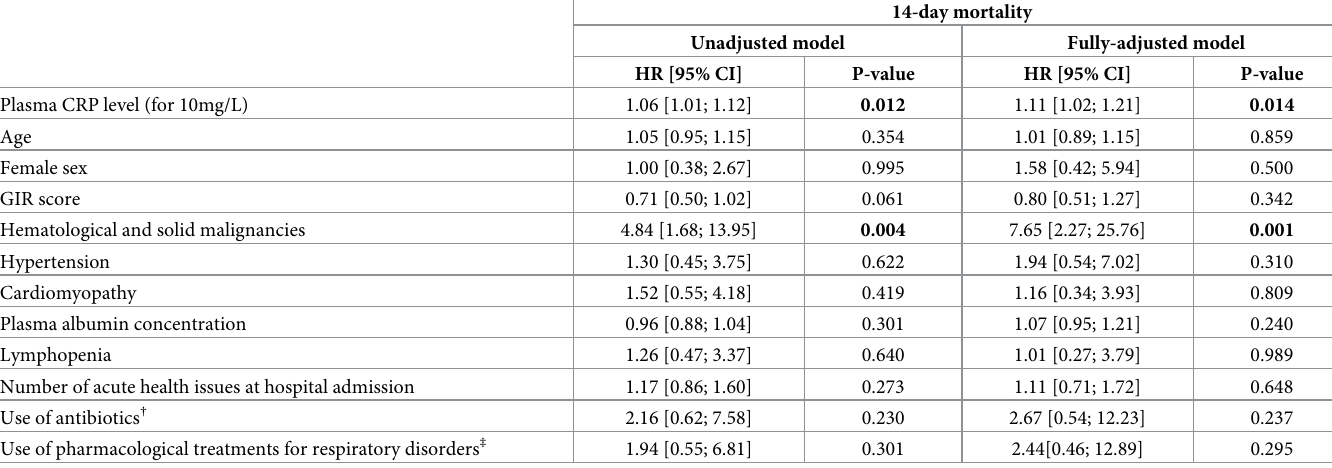
Table 2. Multiple Cox proportional-hazards model showing the hazard ratio for 14-day mortality (dependent variable) according to baseline plasma CRP (indepen- dent variable), adjusted for participants’ characteristics (n = 95).